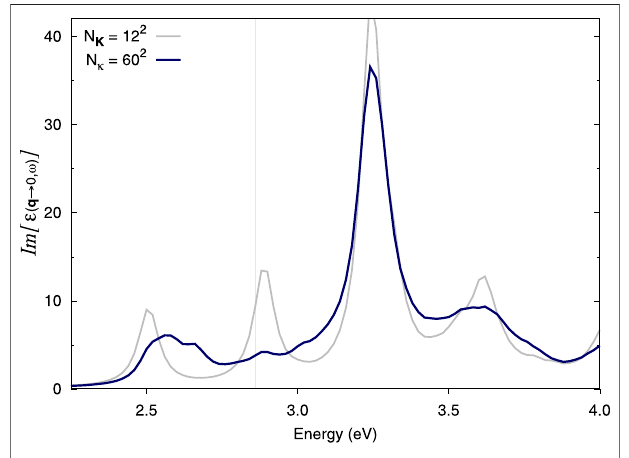
FIGURE3| OpticalabsorptionspectraofmonolayerMoS 2 .BSEspectra calculatedusingthedouble-gridapproachdescribedinthiswork.Spectraare calculated on a 12 × 12 × 1 coarse k -grid and a denser fi ne k -grid, indicated by N κ . N K (cid:2) 12 2 corresponds to a standard calculation on a 12 × 12 × 1 k -gridwhile N κ (cid:2) 60 2 correspondstoadouble-gridcalculationwitha60 × 60 × 1 fi negrid.Weconsiderall e − h pairs fromthetopthreevalencebandstothe fi ve bottom conduction bands. All k -grids are Gamma-centred.